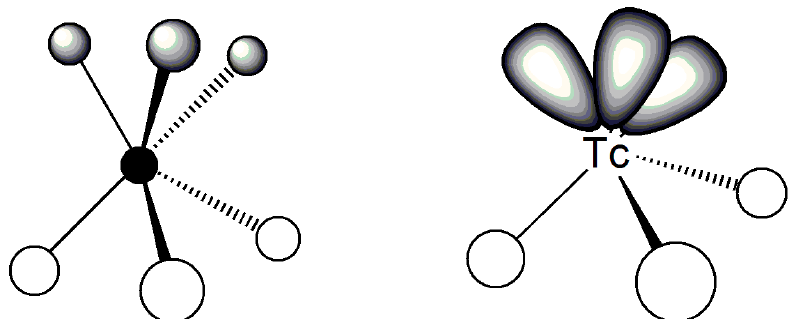
Figure 3. Simplified pictorial representation of the C 3v geometry and of the frontier σ -orbitals for the Tc-trioxo and Tc-tricarbonyl metallic fragments.